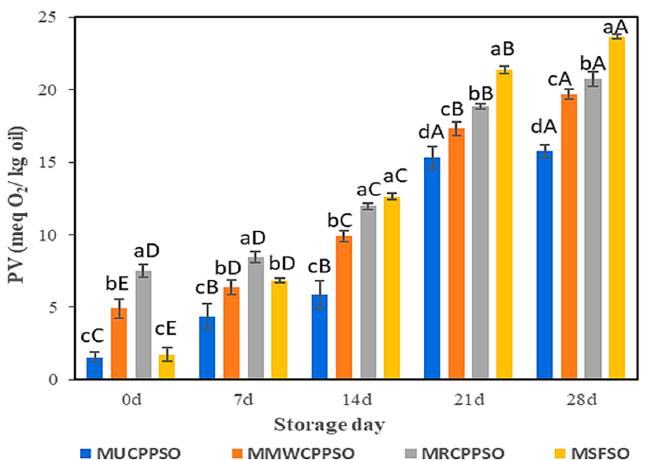
Figure 4. Evolution of the peroxide value of the mayonnaises during storage. Values are means ± standard deviations (SD) of three independent determinations. Different lowercase letters represent significant differences between the mayonnaises ( p < 0.05). Different uppercase letters represent sig- nificant differences between storage times of each mayonnaise ( p < 0.05).